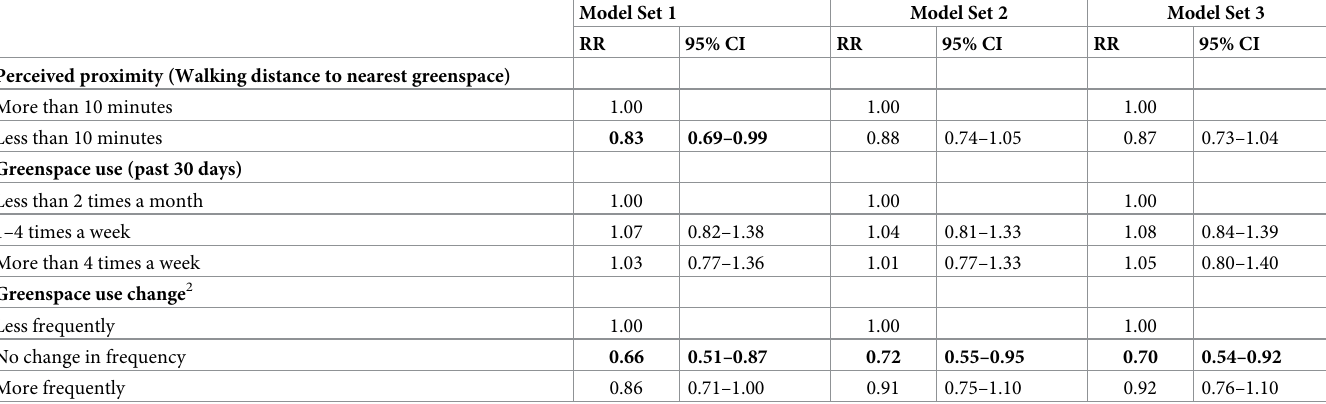
Table 4. Estimates of association between the greenspace measures and worsened feelings of loneliness, comparing the survey period to before the start of pan- demic-related social distancing measures in March of 2020 1